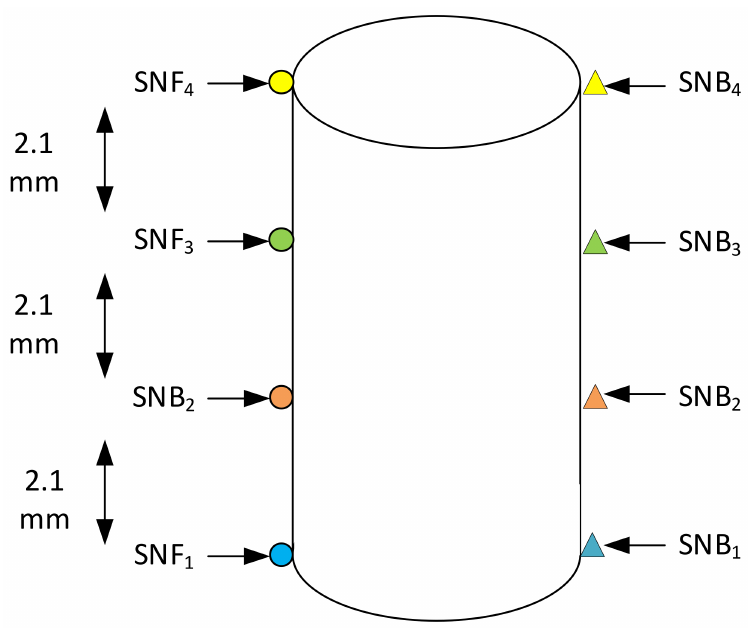
Figure 8. Location of sensor nodes on each of the core pins to determine the flow pressure using